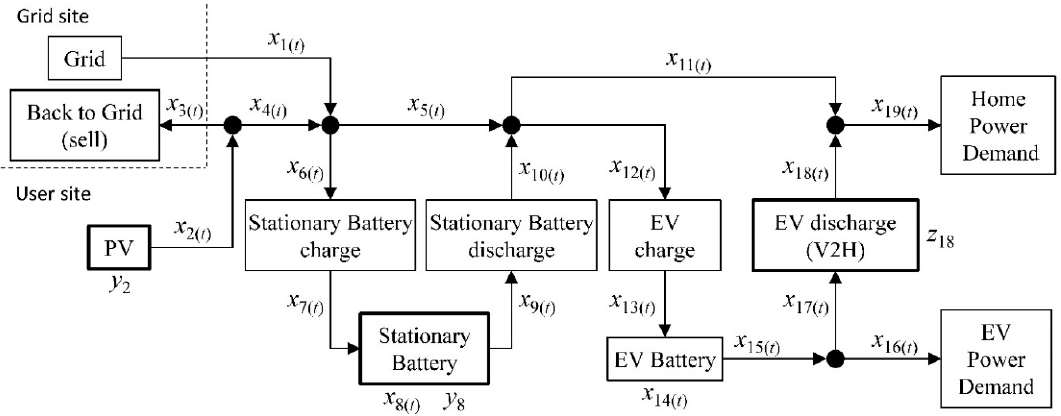
Figure 1. Energy flow structure of the household.